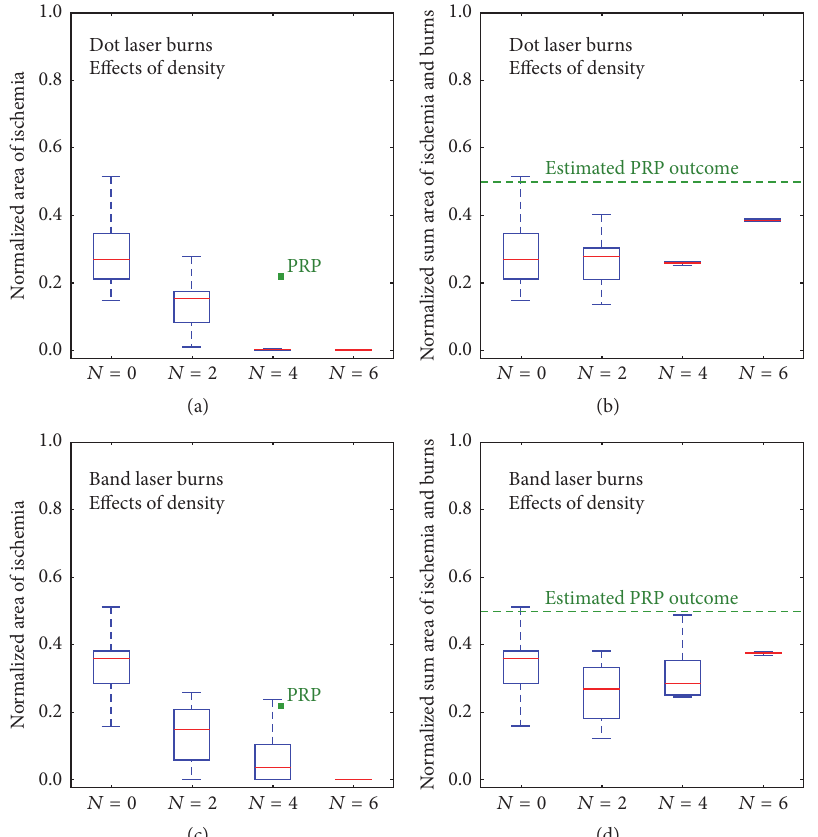
Figure 3: Evaluation of dot pattern and band pattern in terms of coagulated retinal area and predicted ischemic area. Replicate simulations were executed for dot and band patterns , divided into four 𝑁 groups with 𝑁 = 0 , 2, 4, and 6. Note that 𝑁 = 0 represents the control group without photocoagulation whereas other 𝑁 ’s indicate the total number of bands and therefor increasing areas of photocoagulation. For a given 𝑁 , the normalized burn areas are essentially equal for the dot and band patterns. 𝑁 is plotted on the 𝑥 -axis, while the fraction of retina which is ischemic, the normalized area at the end of three simulated years, is plotted on the 𝑦 -axis for the dot (a) and band (c) patterns . Each of these panels also includes standard PRP as a green square. Outcomes from replicate simulations are given as box and whisker plots. (b) and (d) plot 𝑁 equals number of bands or of dot burns of equal total area on the 𝑥 -axis and plot the normalized sum of treated and final ischemic areas on the 𝑦 -axis. Estimated PRP outcome is given based on a 0.28 normalized burn area for the total peripheral retinal [2] plus an estimated ischemic propagation for nontreated retina based on the control